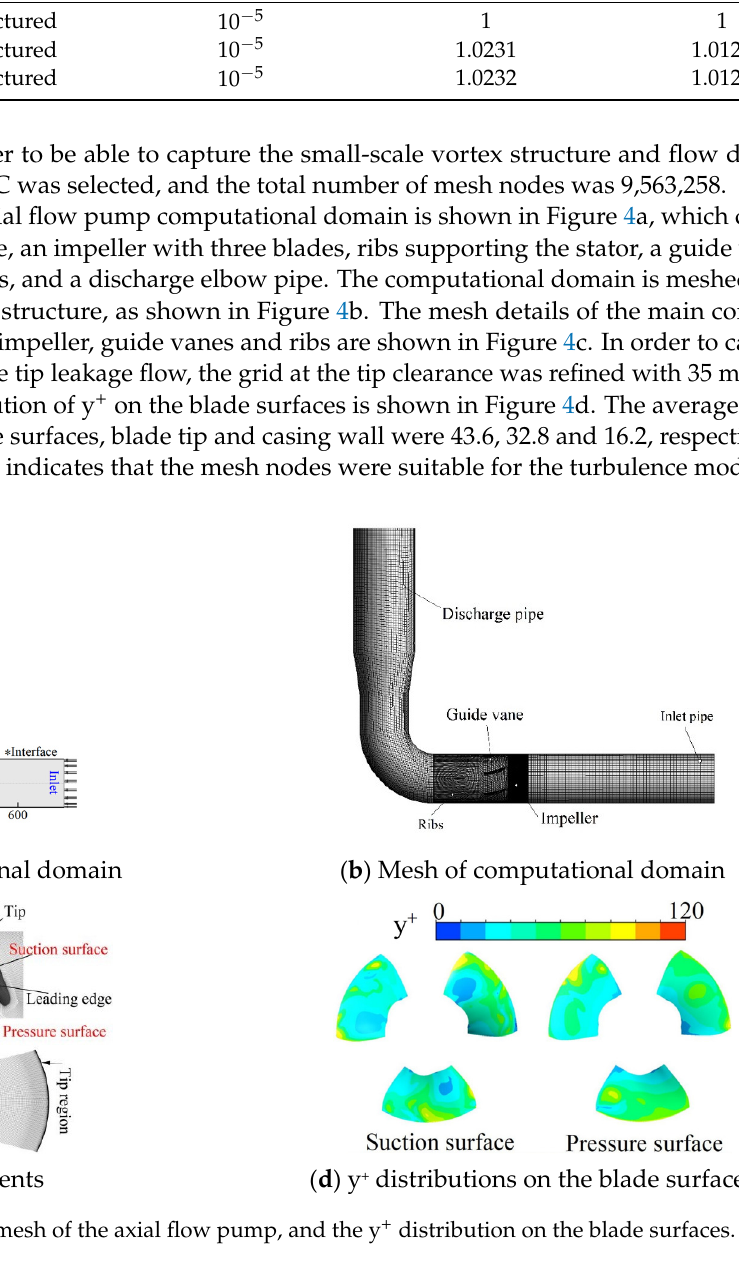
Table 2. Grid-independent results.